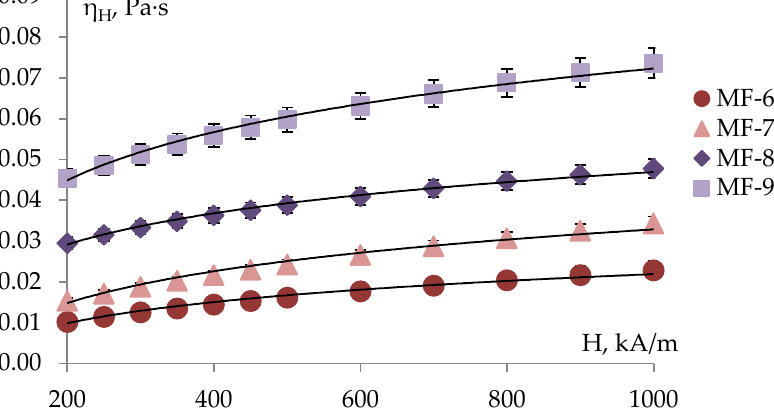
Figure 7. Dependence of viscosity on magnetic field strength for samples MF-6 – MF-9.